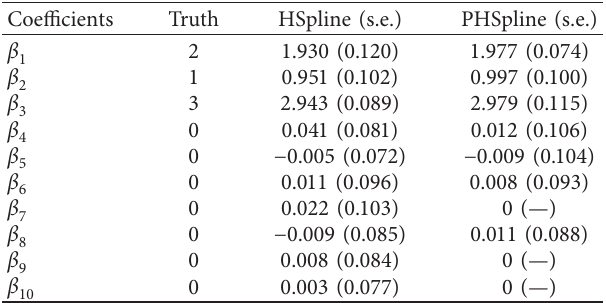
Table 6: Simulation result of Example 4.